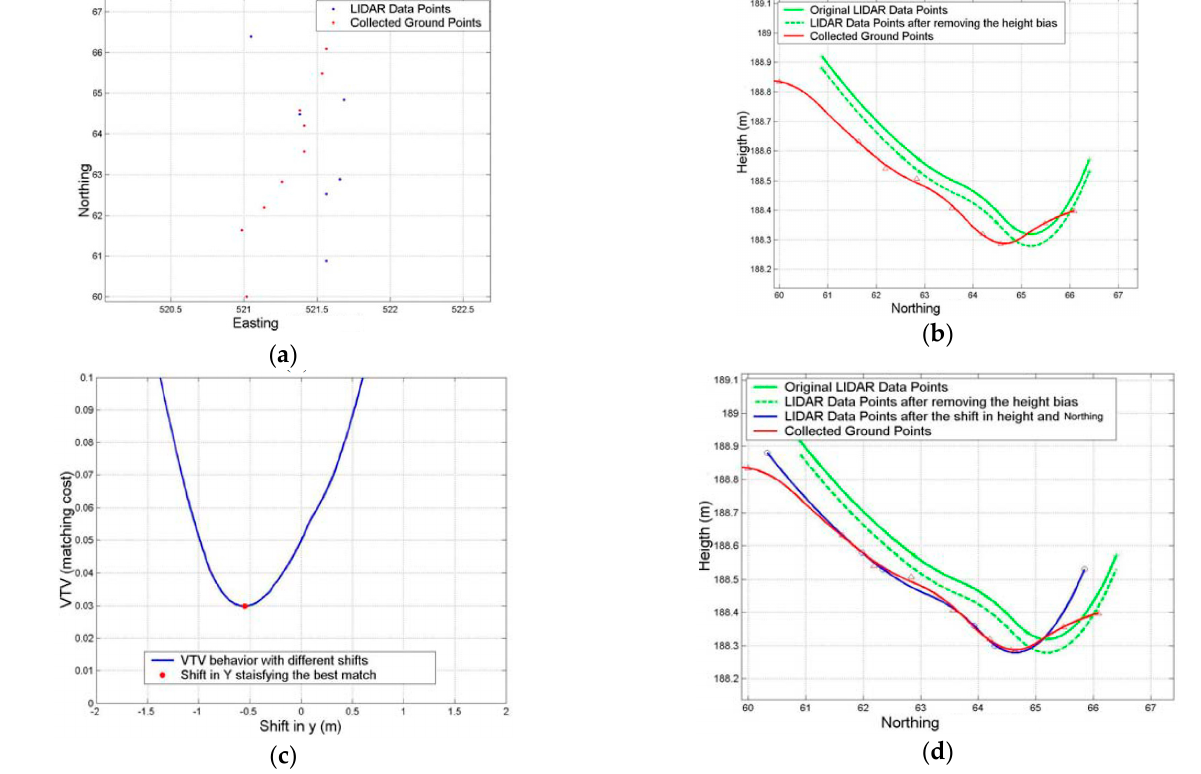
Figure 11. ( a–d ) Planimetric offset in Northing (Y) direction at location G. Figure 11. ( a – d ) Planimetric offset in Northing (Y) direction at location